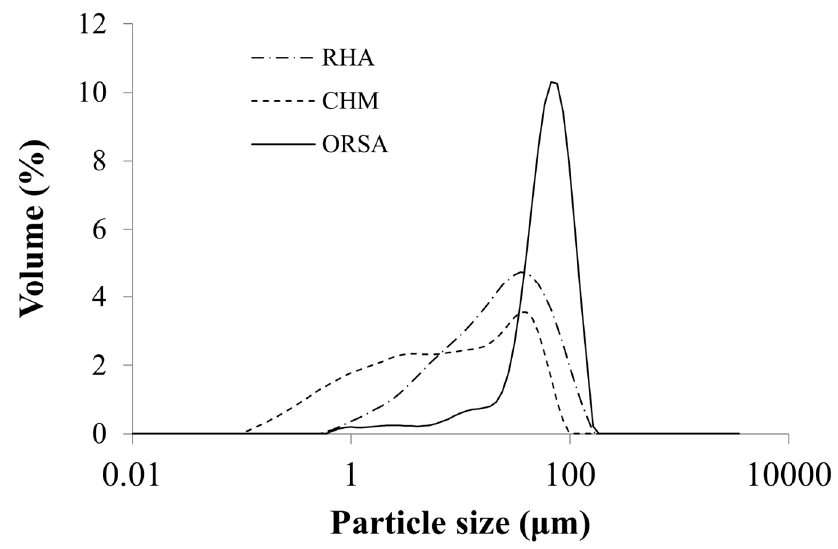
Figure 2. Particle size distribution of raw materials. Rice husk ash (RHA), chamotte (CHM) and oil refining sludge ash (ORSA).